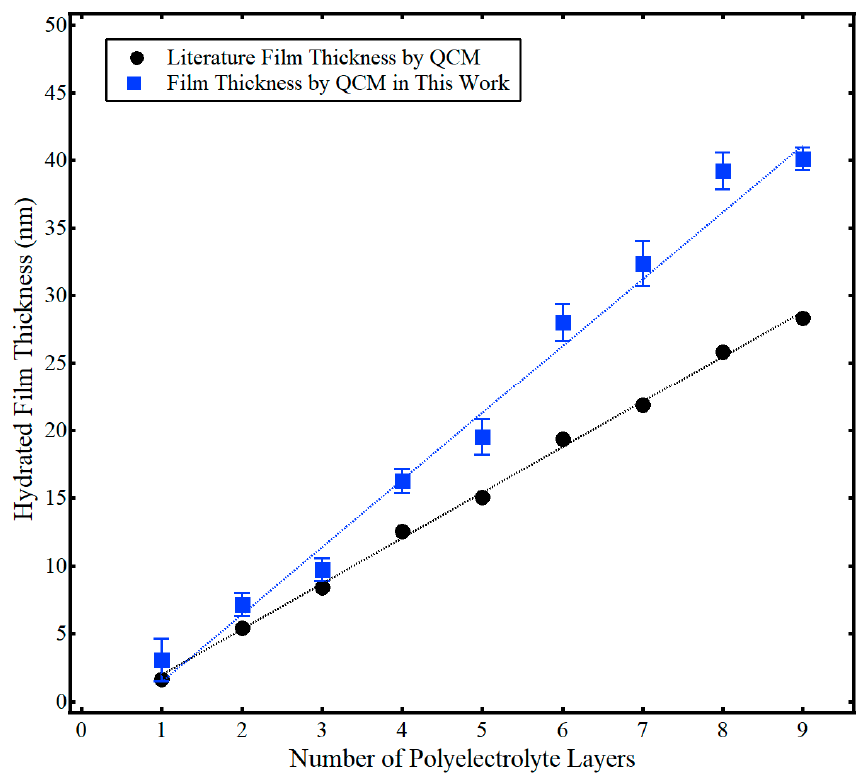
Figure 3. Hydrated film thickness ( d film ) as a function of the number of polyelectrolyte layers determined by QCM in this work ( ■ ) and results from Iturri Ramos et al. using QCM ( ● ) [14]. Error bars indicate one standard deviation from the mean. Dashed lines represent a linear regression and are provided as a guide to the eye. Adapted from Jagoba J. Iturri Ramos, Stefan Stahl, Ralf P. Richter, and Sergio E. Moya Macromolecules 2010 43 (21), 9063-9070. Copyright 2010 American Chemical Society.